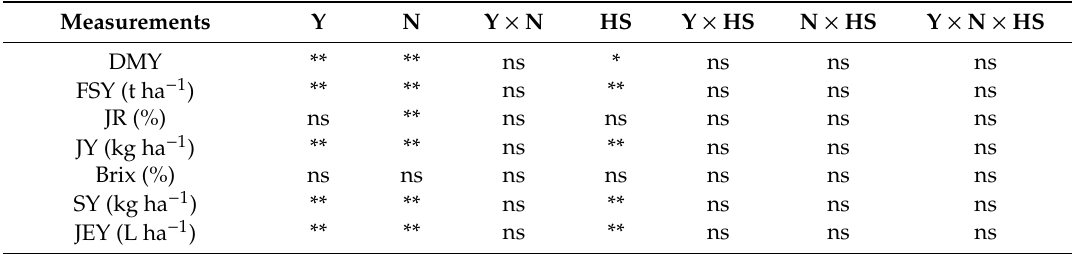
Table 2. Results of traits determined by variance analysis. DMY, dry matter yield; FSY, fresh stem yield; JY, juice yield; SY, sugar yield; JEY, juice ethanol yield; DBY, dry bagasse yield; LEY, lignocellulosic ethanol yield; TEY, total ethanol yield; LHV, lower heating